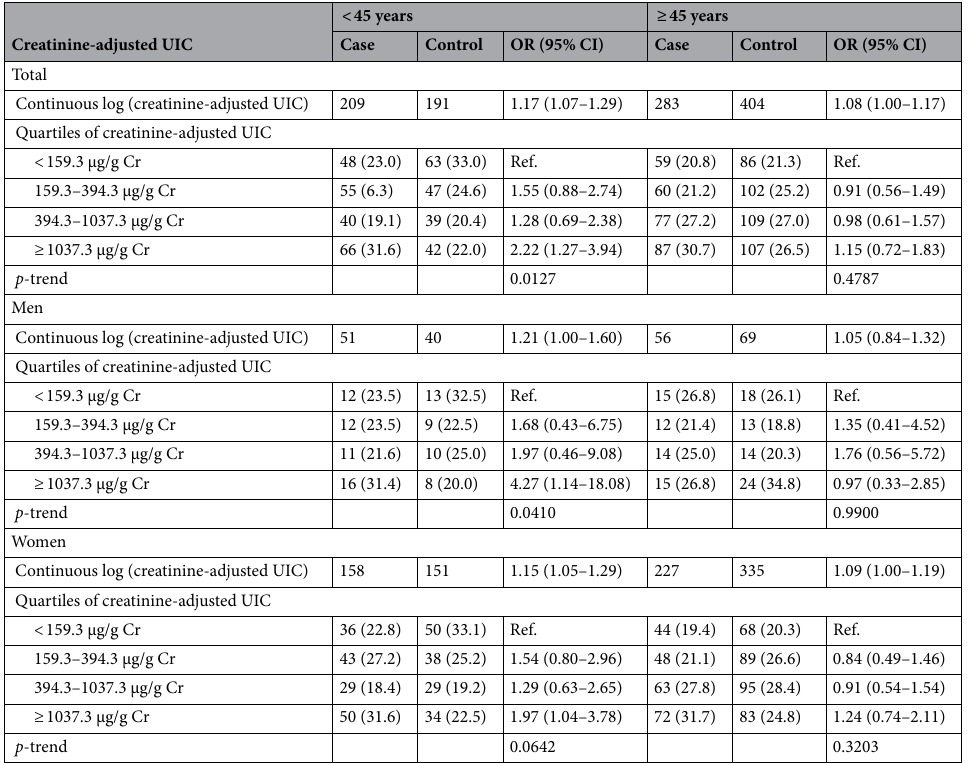
Table 4. The odds ratios (ORs) and 95% confidence intervals (CIs) of the risk of PTC for creatinine-adjusted UIC among 492 case patients with PTC and 595 control patients with benign thyroid diseases stratified by age 45 years old and sex. PTC papillary thyroid cancer, UIC urinary iodine concentration. *Adjusted for education level, physical activity, supplement intake, BMI, daily alcohol intake, smoking status, family history of cancer, and history of benign thyroid diseases. p for interaction in total = 0.1172; in men = 0.2428; in women =